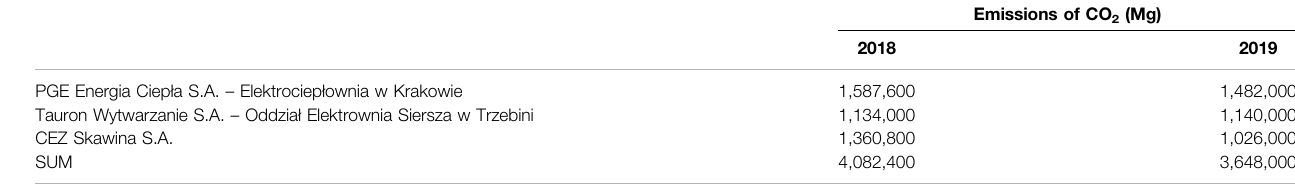
TABLE 3 | Estimated amounts of carbon dioxide emissions by 3 power plants/combined heat and power plants in Ma ł opolska in 2018 and 2019 – summary 4 .